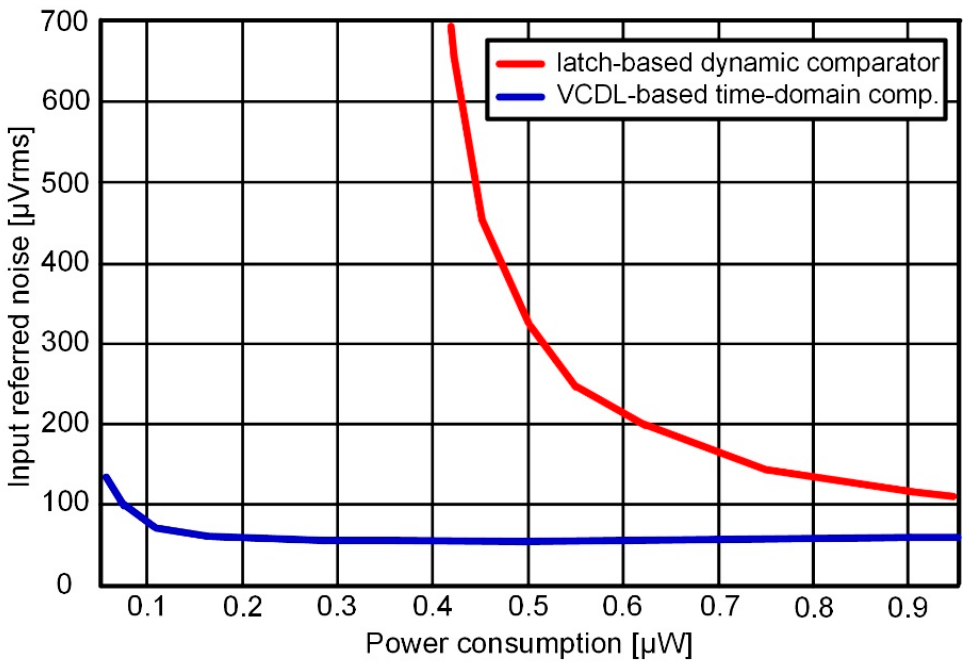
Figure 3. Input-referred noises of a latch-based dynamic comparator and VCDL-based time-domain comparator according to power consumption.